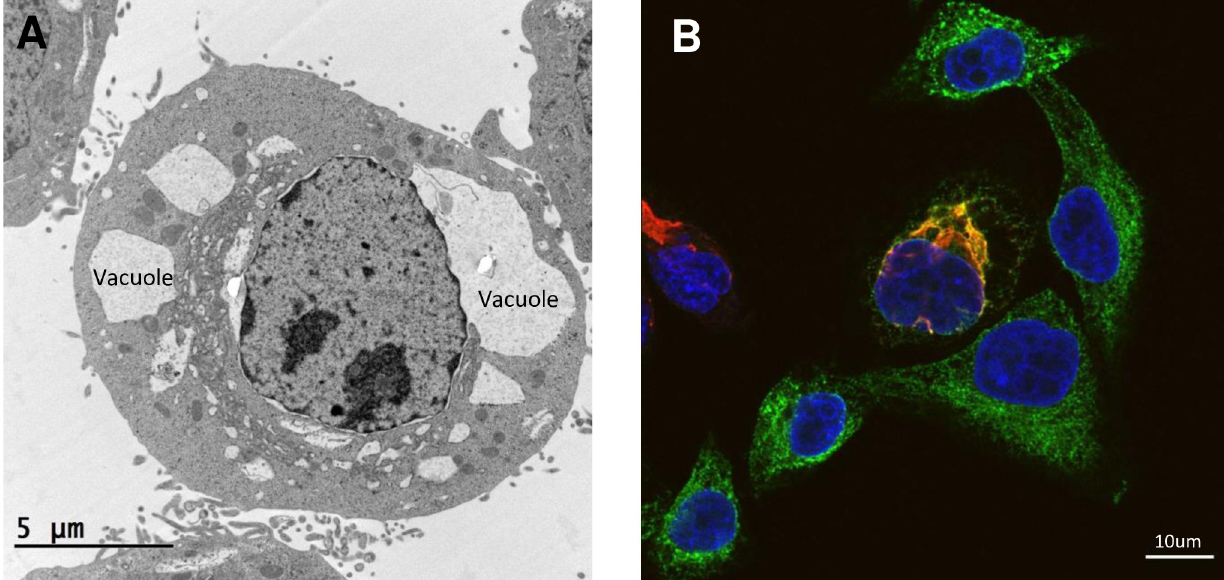
Fig 1. Microscopy images of ZIKV-infected HeLa Cells 24 hours after infection. (A) Electron micrograph of ER-derived vacuoles in a ZIKV-infected cell. (B) Confocal microscopy image showing the colocalization (yellow/orange) of ER-shaping protein ATL3 (green) with the ZIKV protein NS3 (red). ATL3, Atlastin-3; ER, endoplasmic reticulum; NS3, nonstructural protein 3; ZIKV, Zika virus.